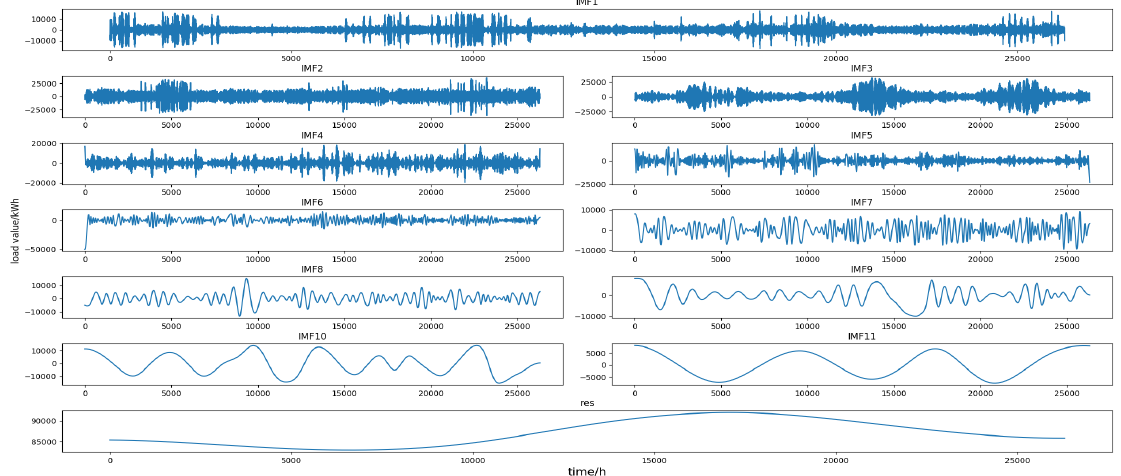
Figure 7. M_3 load series decomposition results.